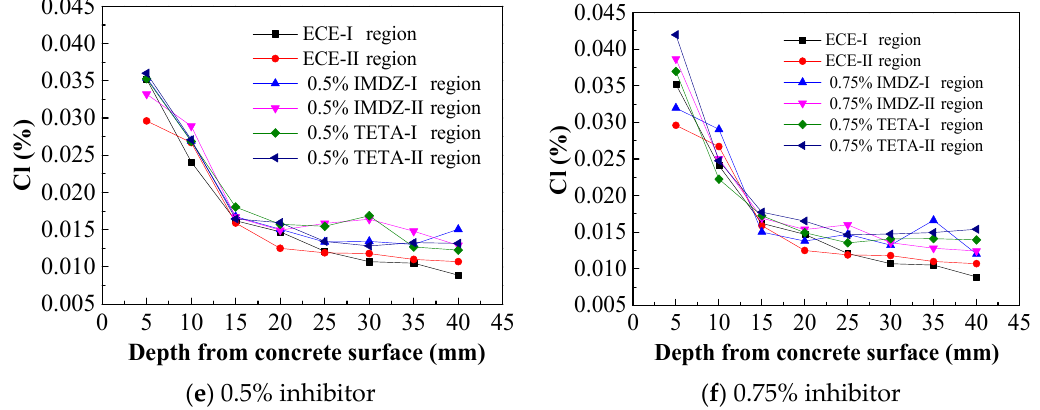
Figure 8. Chloride concentration in concrete.